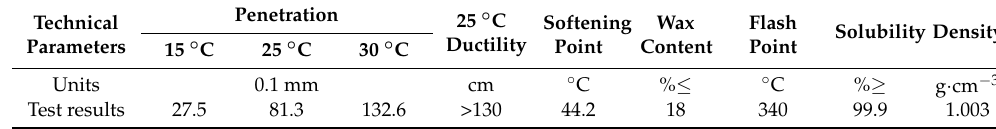
Figure 1. Oil shale waste (OSW) in a power plant in Jilin province China. Table 1. Technical parameters of ‘Pan Jin’ asphalt.